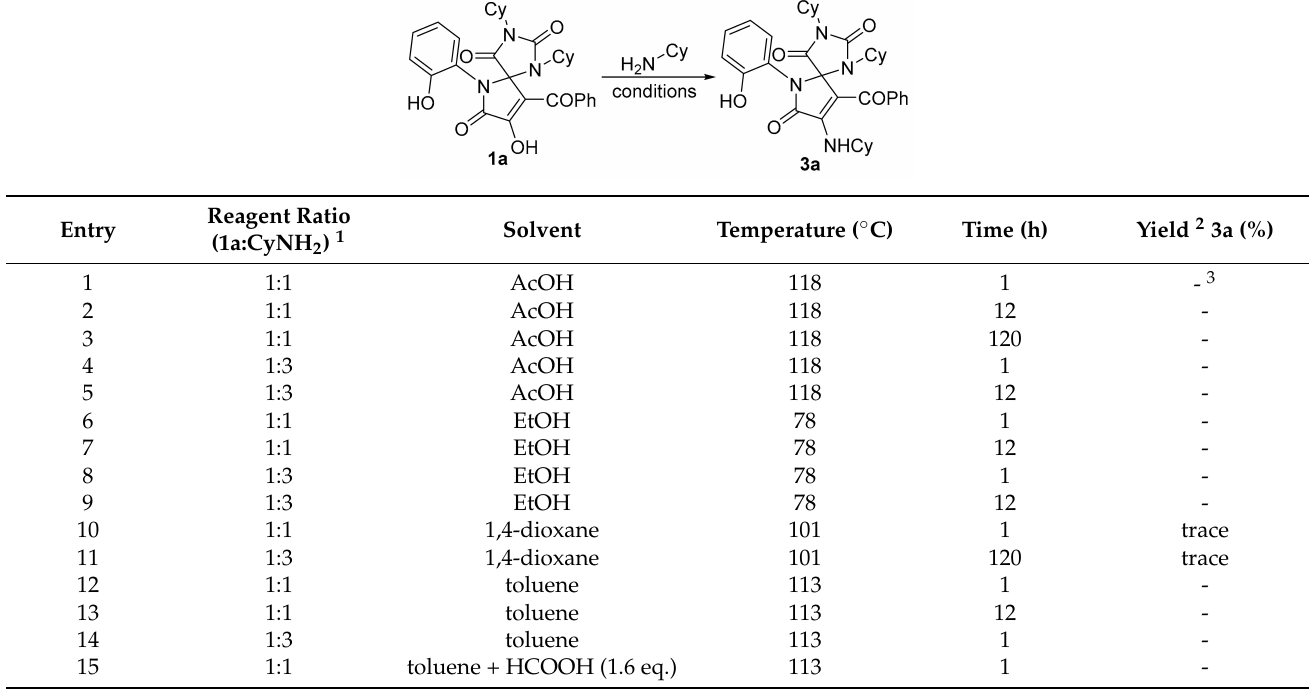
Table 1. Reaction of spiro HDP 1a with cyclohexylamine under various conditions.